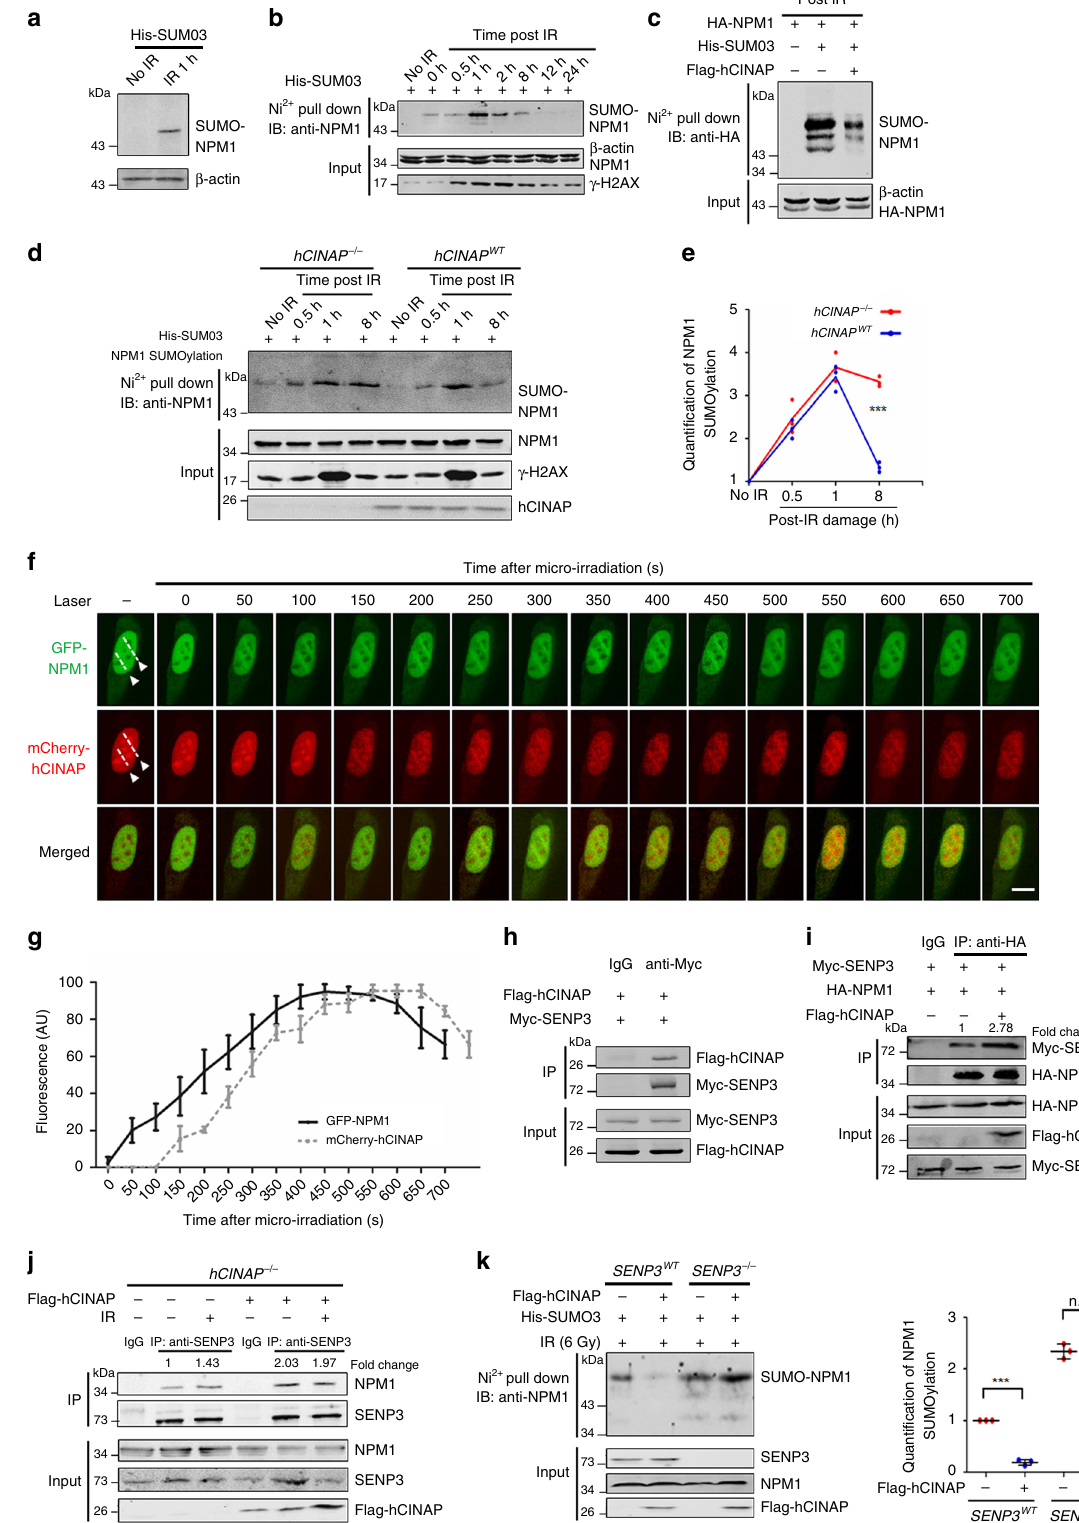
treatment. The hCINAP − / − U2OS cells had much more BRCA1 foci than hCINAP WT cells in the resting state. After exposure to irradiation, BRCA1 foci in hCINAP − / − cells were more abundant than in hCINAP WT cells. At 1 h after irradiation, hCINAP − /